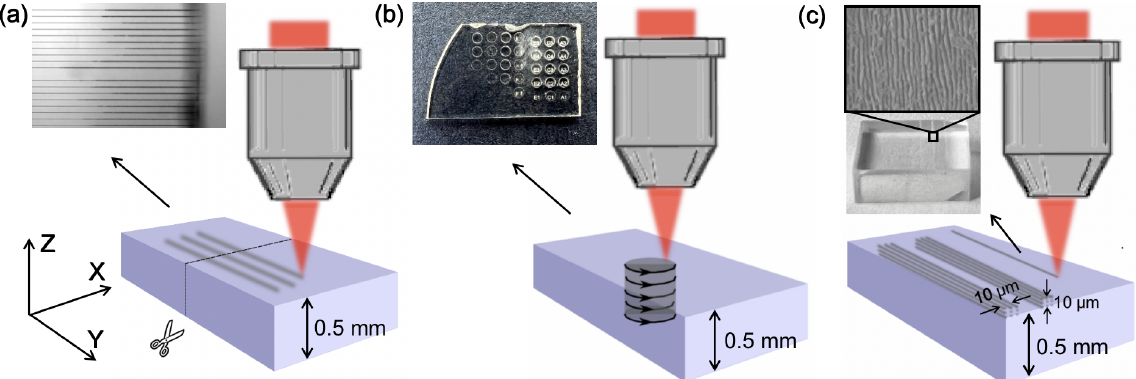
Figure 1. The schemes and the resulting pictures after the etching of performed experiments. ( a ) Single lines experiment when lines from a single scanning are written in the volume of material to test the etching rate of modified material. ( b ) Scheme of 3D experiments when cylindrical structures are written through the whole plate thickness. ( c ) Laser-induced surface changes for modification morphology observation after the etching